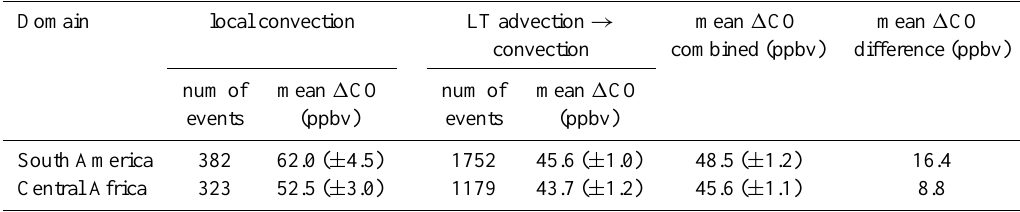
Table 1. Annual statistics of the two transport pathways. From left to right: first column indicates the domains; second and fourth columns indicate the total number of identified “local convection” and “LT advection → convection” transport events, respectively; third and fifth columns indicate the average CO increase associated with “local convection” and “LT advection → convection”, respectively; sixth column indicates the average CO increase associated with the combination of both pathways; seventh column indicates the difference between the average CO increase associated with “local convection” and the average CO increase associated with “LT advection → convection”. The numbers in the parentheses are ± 2 standard errors of the